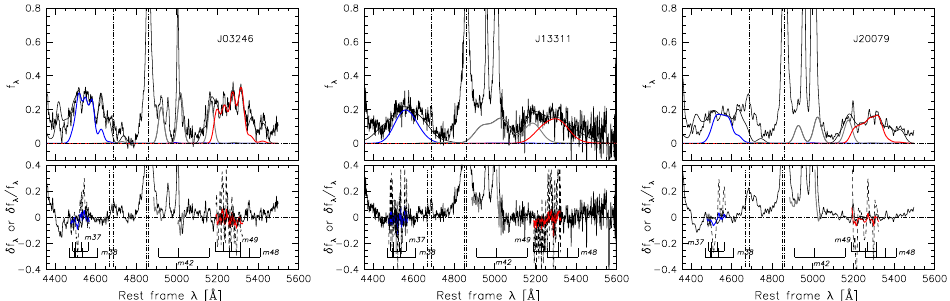
Figure 8. Non-linear χ 2 multi-component analysis with a Fe II template with relative multiplet intensity free to vary, from left to right for the A1 RQ vs. A1 CD, B1 RQ vs. B1 CD, B1 RQ vs. B1 FR-II composites. The bottom panels show the ratios between the B, m42, and R for the three cases. Colours as in Figure